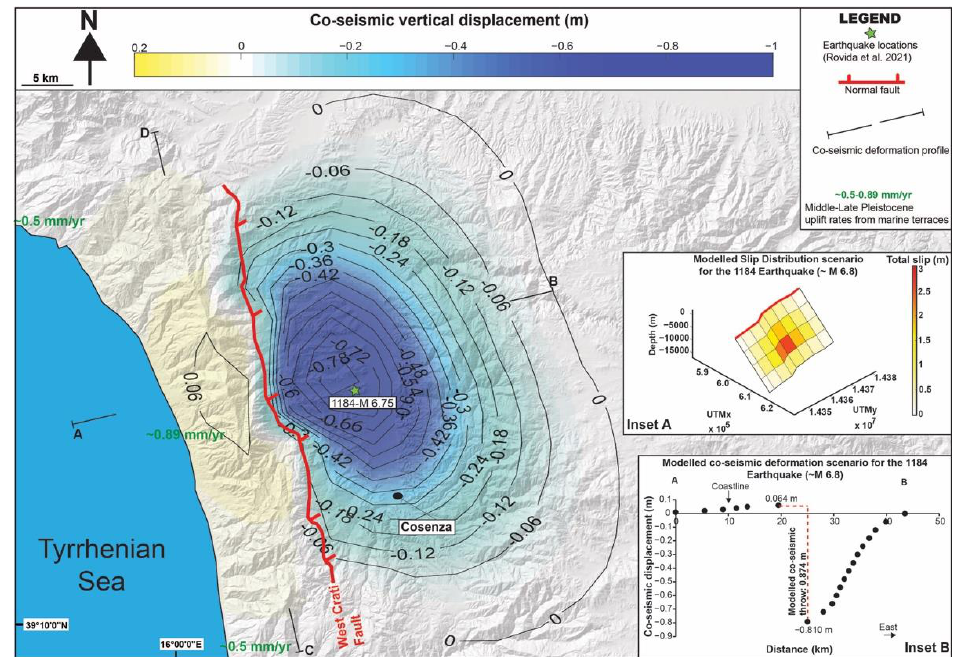
Figure 10. Modelled co-seismic displacement showing co-seismic uplift and subsidence if the entire fault length of the West Crati Fault (~40 km) would seismically rupture, producing a modelled earthquake of M 6.8. Inset A shows a 3D view of the modelled seismogenic source (the West Crati Fault) with the associated slip distribution in depth, with a maximum value of 3 m. Co-seismic uplift/subsidence contours produced by our preferred modelled fault in the half-elastic space are shown along the profile A-B, with a maximum co-seismic uplift and subsidence of 0.064 m and 0.810 m, respectively, Inset B. Furthermore, a crustal deformation profile (C-D) is produced comparing the co-seismic and long-term footwall uplift along the strike of the fault (Figure S11). Note that the estimated magnitude for the 1184 “Valle del Crati” earthquake is 6.75 and matches our modelled magnitude (M 6.8); moreover, the location of this historical seismic event lies where we estimate the maximum co-seismic subsidence.